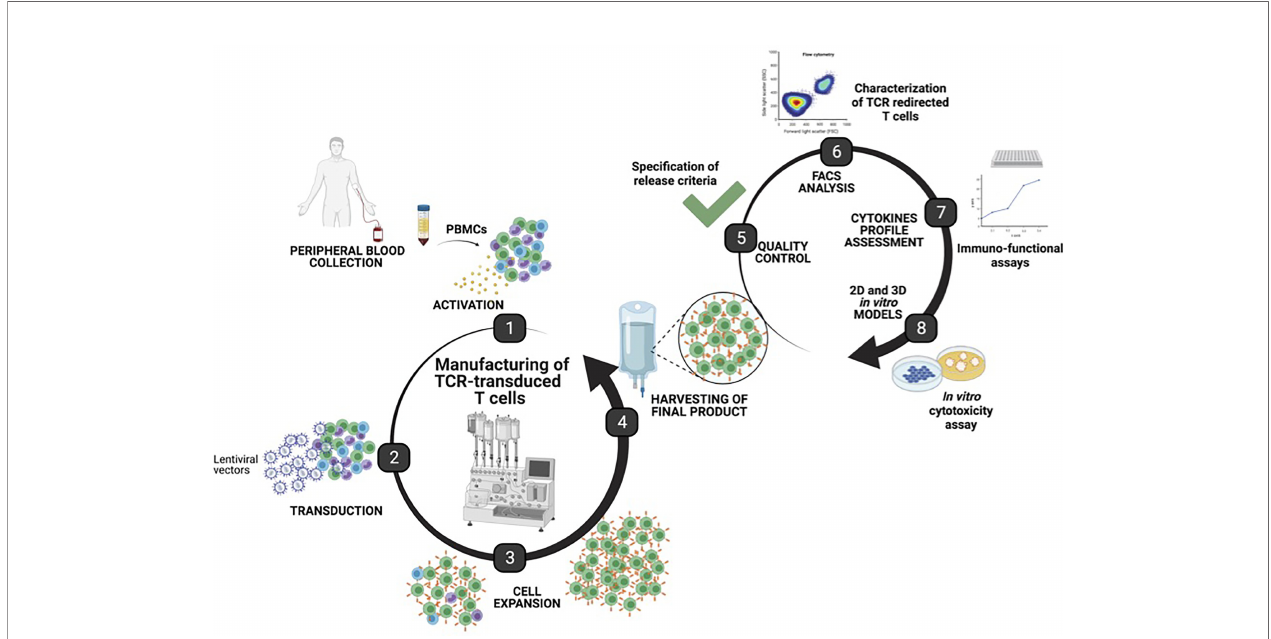
FIGURE 1 | Manufacturing of T cell receptor (TCR)-T cells using the CliniMACS Prodigy. Graphical representation of the manufacturing steps for TCR-T cells using the automated, closed CliniMACS Prodigy platform (steps 1 – 4). Frozen peripheral blood mononuclear cells were obtained from healthy donor buffy coat and used as starting material for the activation, transduction, and expansion of T cells under optimized conditions. After 8 days of expansion, samples from the harvested fi nal products were taken for safety quality controls, and characterization of TCR-T cells was performed to determine the purity, T cell phenotype, transduction ef fi ciency, functionality, and cytotoxic potential as assessed by 2D and 3D in vitro models (created with